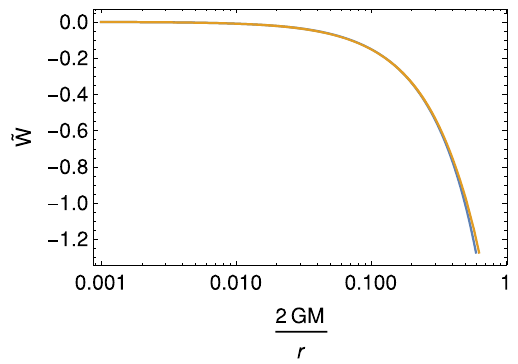
Fig. 1 (cid:29) W Vs. 2 GM / r . Blue and yellow curves show numerical solu- tion of Eq. (43) and analytical solution of Eq. (44) for (cid:29) W respectively